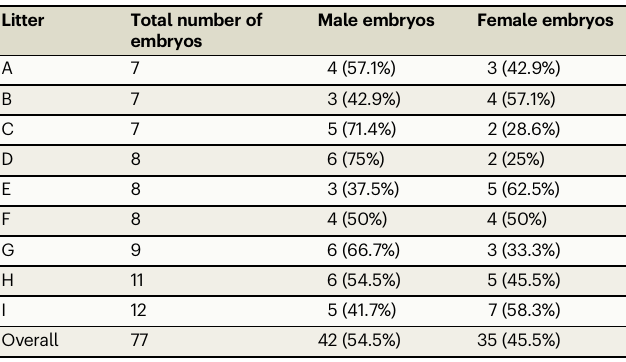
Table 2 | Sex of embryos from 9 individual litters used to obtain neural progenitor cells